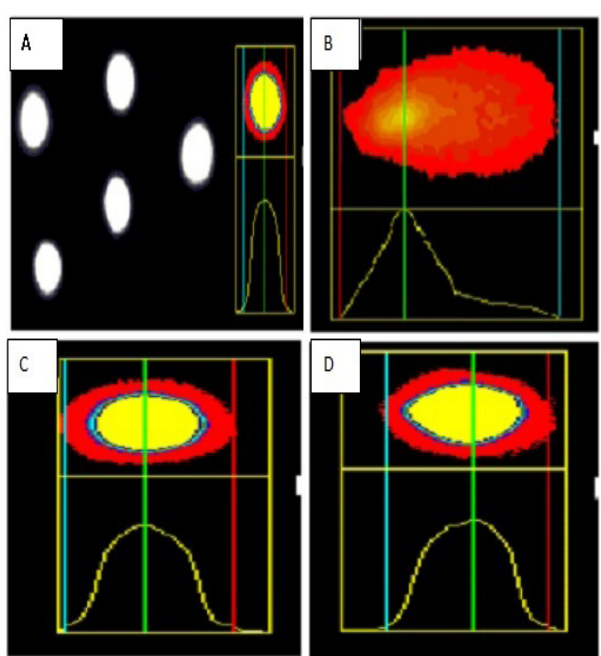
FIGURE 3 - Representative Comet images of dPC12 cells. A: Control (untreated human lymphocytes), B: H human lymphocytes C: 500 µg/mL G. corniculatum methanol extract pre-treated human lymphocytes D: 500 µg/mL G. corniculatum water extract pre-treated human lymphocytes.